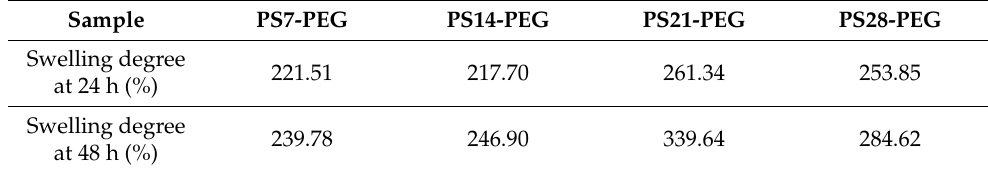
Figure 10. ( a ) Swelling degree with soaking time; ( b ) morphology of PS21-PEG hydrogel before and after swelling. Table 1. Swelling degree of studied